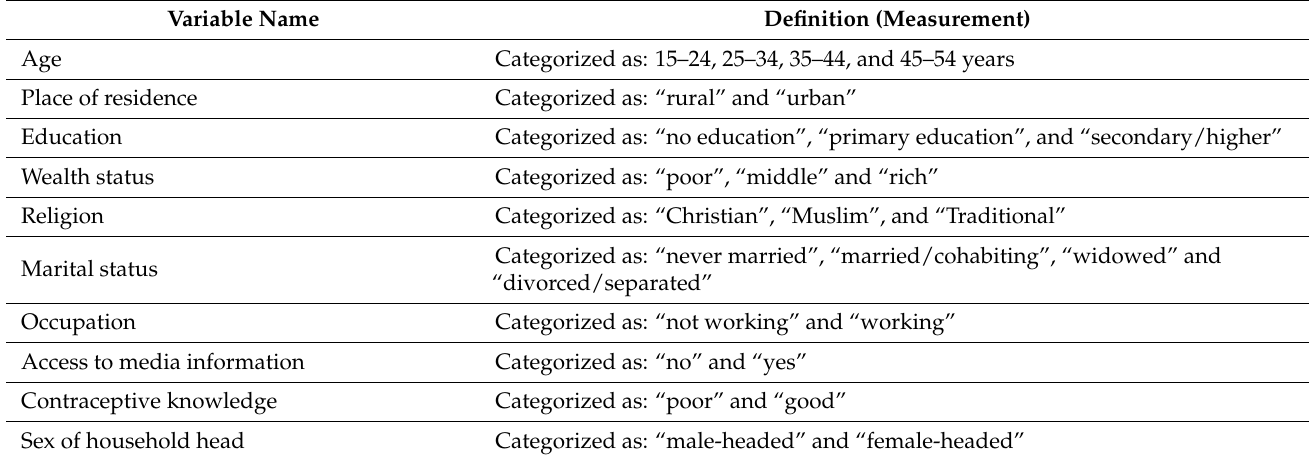
Table 1. The lists of independent variables and their definitions and